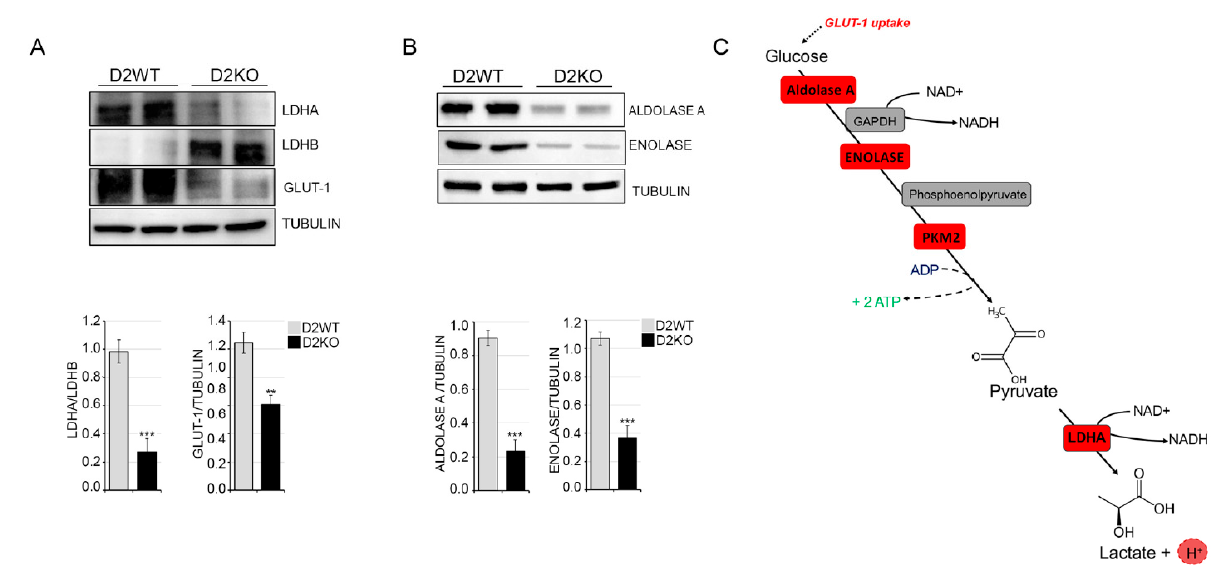
Figure 6. Loss of D2 attenuates tumor metabolic reprogramming. Western blot analysis of LDHA, LDHB and GLUT-1 expression in skin lesions of D2WT and sD2KO mice ( n = 15 for both groups) treated with DMBA/TPA for 20 weeks. Quantification of the single protein versus tubulin levels is represented by diagrams (bottom). ( B ) The protein expression levels of Aldolase A and Enolase in tissue samples are as indicated in ( A ), and the relative quantifications of the single protein levels are represented by diagrams (bottom). Each experiment was performed in triplicate. Results are expressed as the mean ± SD. ** p < 0.01, *** p < 0.001. ( C ) Schematic representation of the glycolytic process and the key glycolytic enzymes increased by TH treatment (in red).